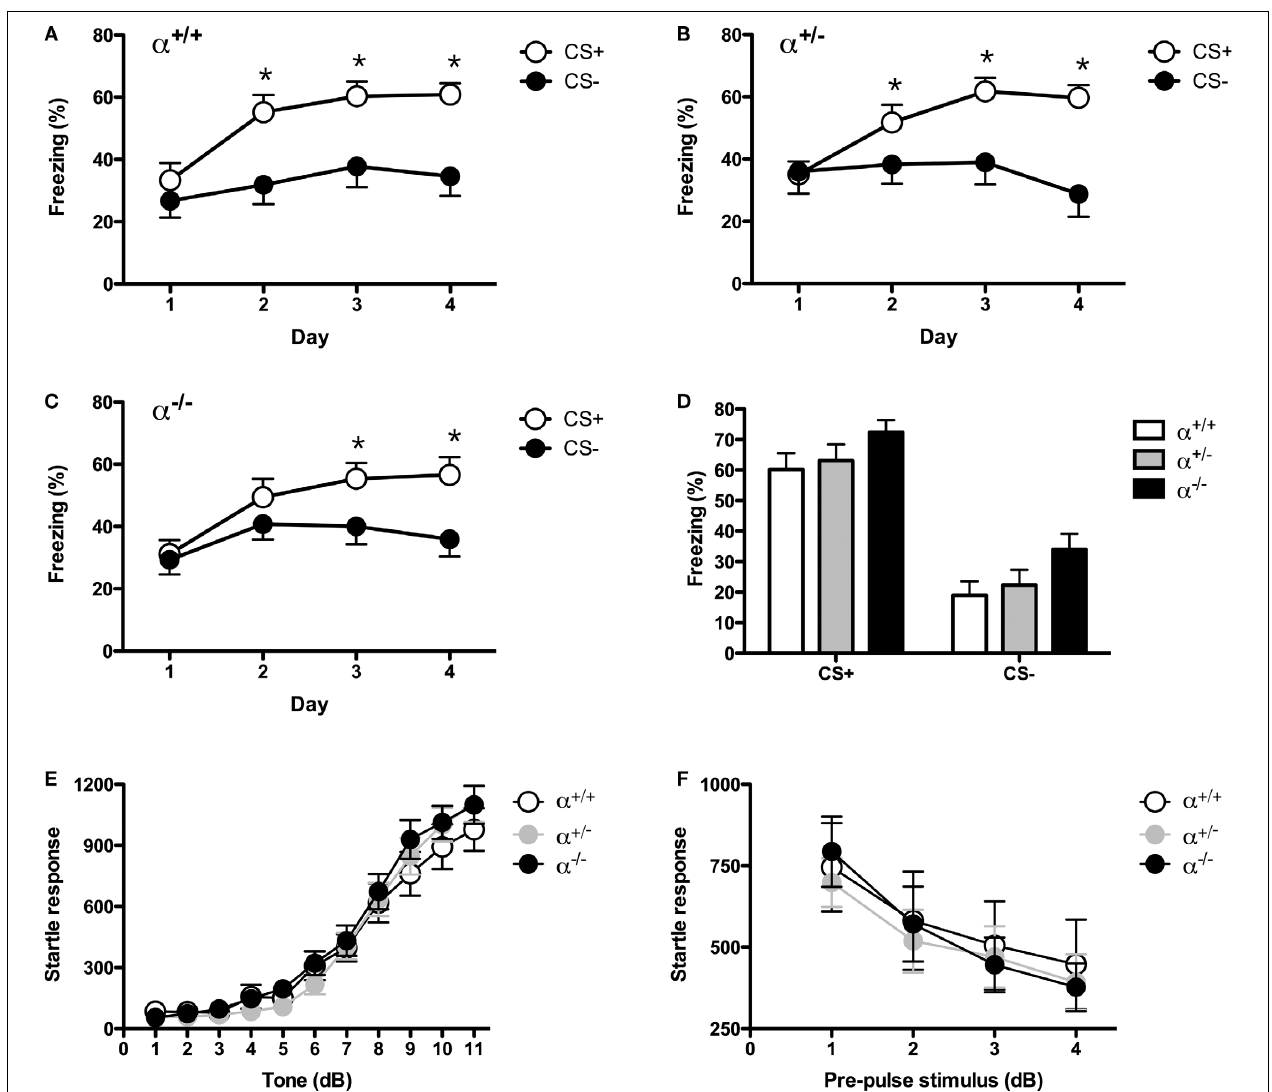
FIGURE 4 | (A) Mice were trained with a white noise and clicker auditory stimulus. For each animal, one of these stimuli was paired with shock (CS + ) and the other was not (CS − ). Mice received discrimination training across 4 days. Each day, the CS + and CS − were presented four times in a pseudorandom order (3 min ITI). α 1 + / + control mice learned to discriminate across training days and eventually froze more to the CS + than the CS − . (B) Heterozygous knockout mice learned to discriminate across training days and eventually froze more to the CS + than the CS − . (C) Homozygous knockout mice learned to discriminate across training days and eventually froze more to the CS + than the CS − . (D) The day after discrimination training ended mice were given an extinction test. During this test, the CS + and CS − were each presented four times in the absence of shock. As observed during training, all mice froze signifi cantly more to the CS + than